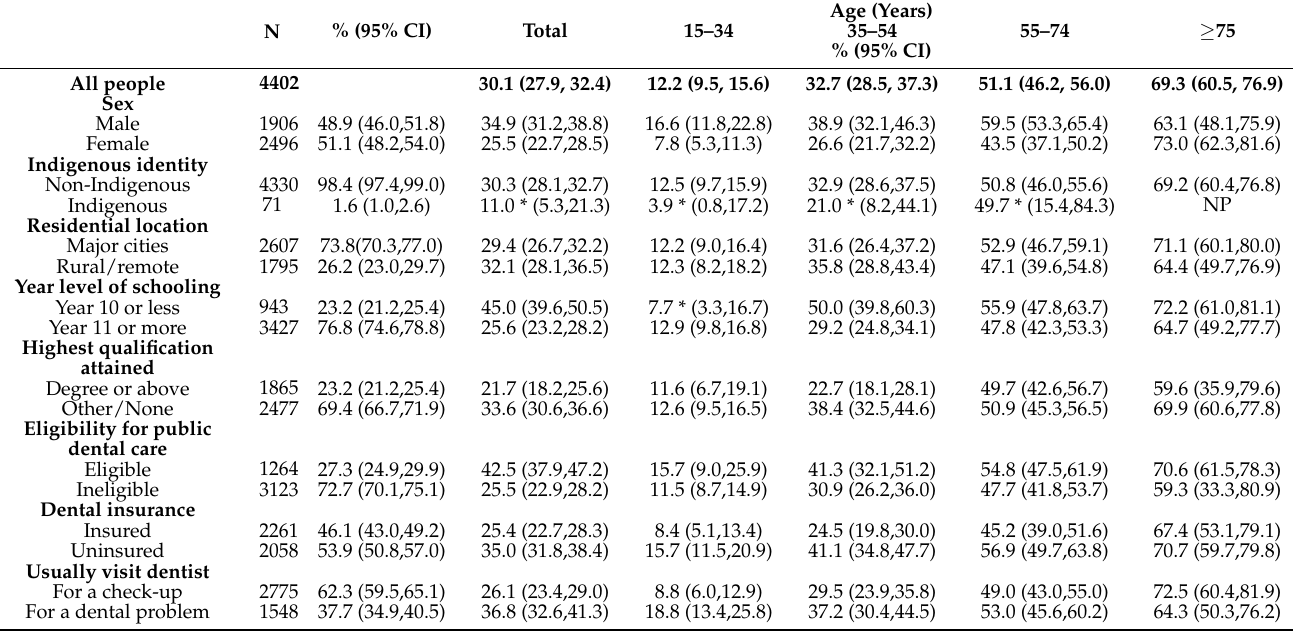
Table 5. Proportion of people with moderate or severe periodontitis in the Australian dentate population.